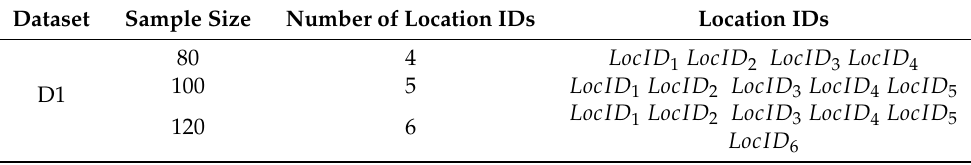
Table 4. The location IDs of service 1 ’s streams at sample sizes of 80, 100 and 120 for dataset D1.